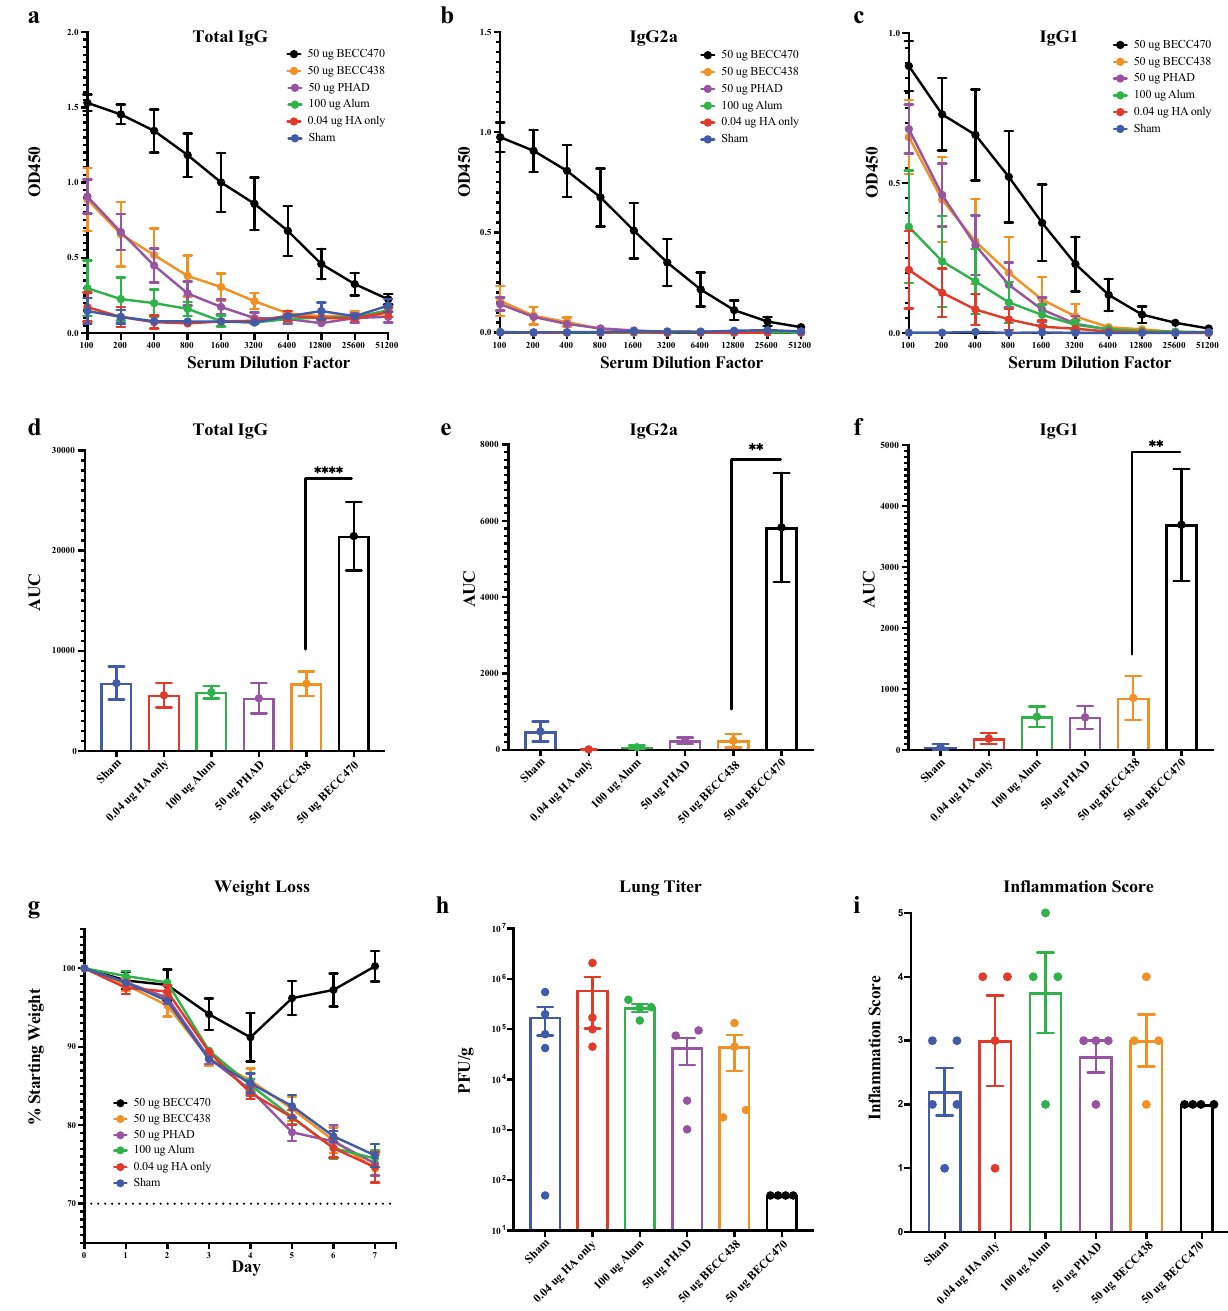
Figure 1. Protection of aged mice following prime + boost vaccination (0.04 μg HA). ( a ) Pre-infection day 28 H1-specific serum ELISA total IgG, ( b ) isotype subclass specific IgG2a and ( c ) IgG1 of aged BALB/c mice vaccinated with 0.04 µg Cal/09 rHA protein in combination with 100 µg alum, 50 µg PHAD, 50 BECC438 or 50 µg BECC470 adjuvant in prime + boost schedule (mean ± SEM). Area under the curve (AUC) (mean ± standard error of the mean) of above serum ELISA curves for ( d ) total IgG (****p < 0.0001), ( e ) IgG2a (**p = 0.0022) and ( f ) IgG1 (**p = 0.0013). ( g ) 7-day weight loss in BALB/c mice (5 per group) after infection with 32,000 PFU of NL/09 (mean ± SEM). ( h ) Virus titer of lung homogenate 7-days post infection (mean ± SEM) with ( i ) pathology inflammation scoring of lung histology slides (mean ± SEM). Prism 9 used to calculate mean + SEM and AUC ± standard